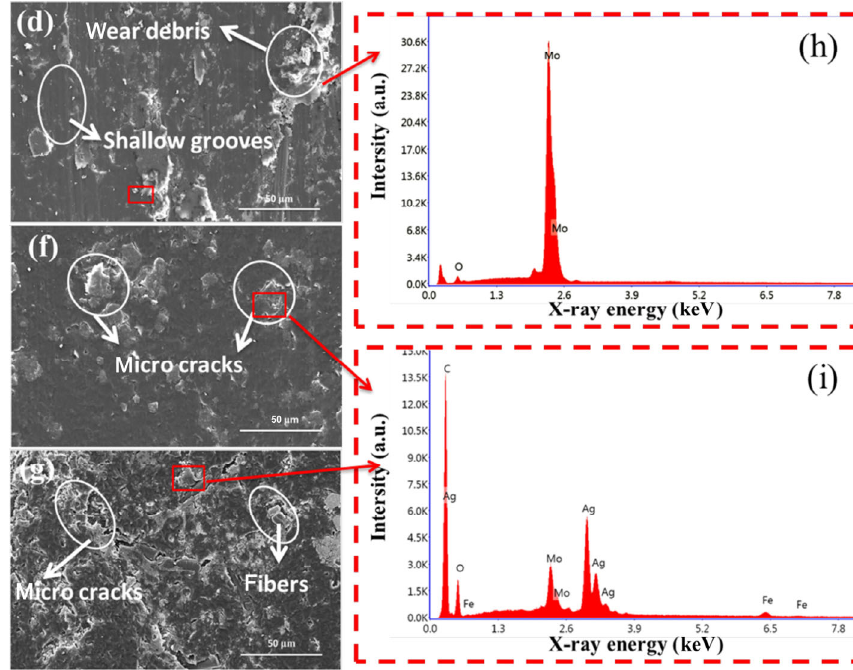
Fig. 5 (h) and (i): EDS analyses of the transfer films formed on GCr15 at different